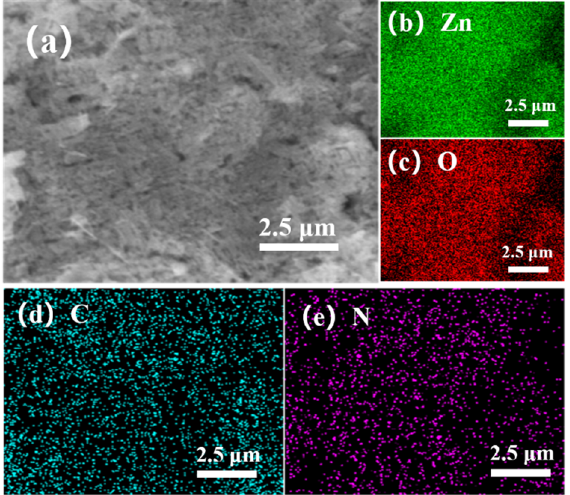
Figure 6. ( a ) SEM scan of 20-ZnO@ZIF-8, and distribution of ( b ) Zn, ( c ) O, ( d ) C and ( e ) N in surface scan.